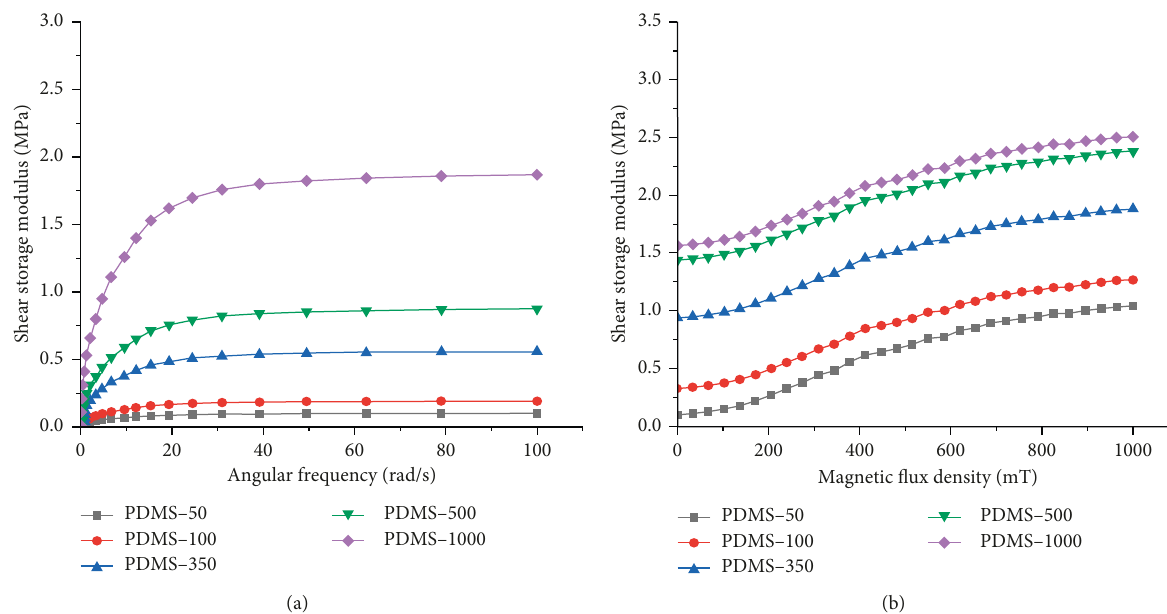
Figure 5: (a) The RSE of the continuously changing angular frequency from 0.1 to 100rad/s and (b) the RME of the continuously changing magnetic flux density from 0 to 1000mT with different PDMS viscosities. Table 6: The changing orders of magnitude of the shear storage modulus with different PDMS viscosities. PDMS viscosity 50 Changing orders of magnitude of the MRSP shear storage modulus